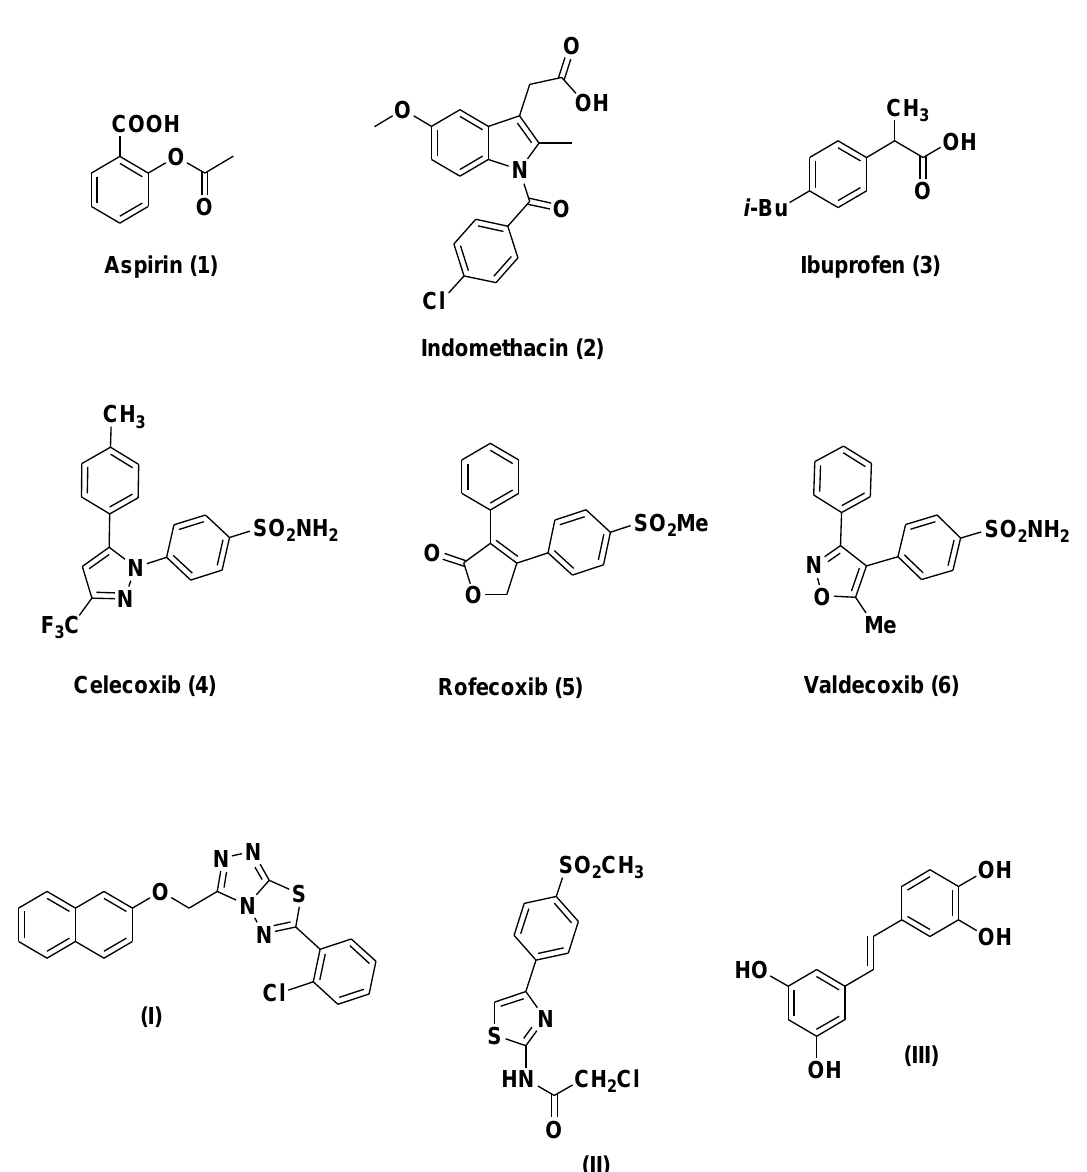
Figure 1. Traditional NSAIDs chemical structures; aspirin ( 1 ), indomethacin ( 2 ) and ibuprofen ( 3 ), selective COX-2 inhibitors; Celecoxib ( 4 ), rofecoxib ( 5 ), valdecoxib ( 6 ) and some reported selective Cox-2 inhibitors of diverse chemical structures ( I – III ).